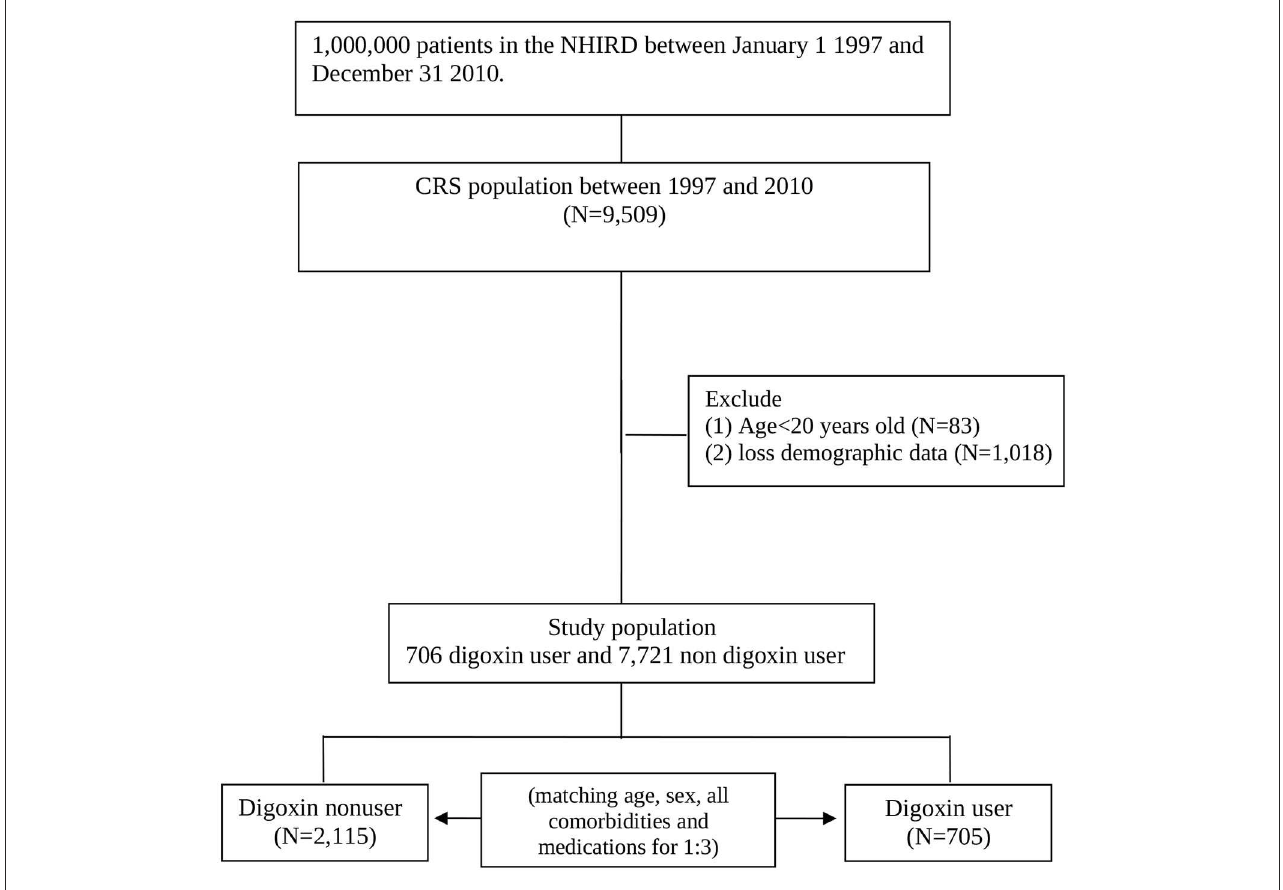
FIGURE1 Flow diagram of the study